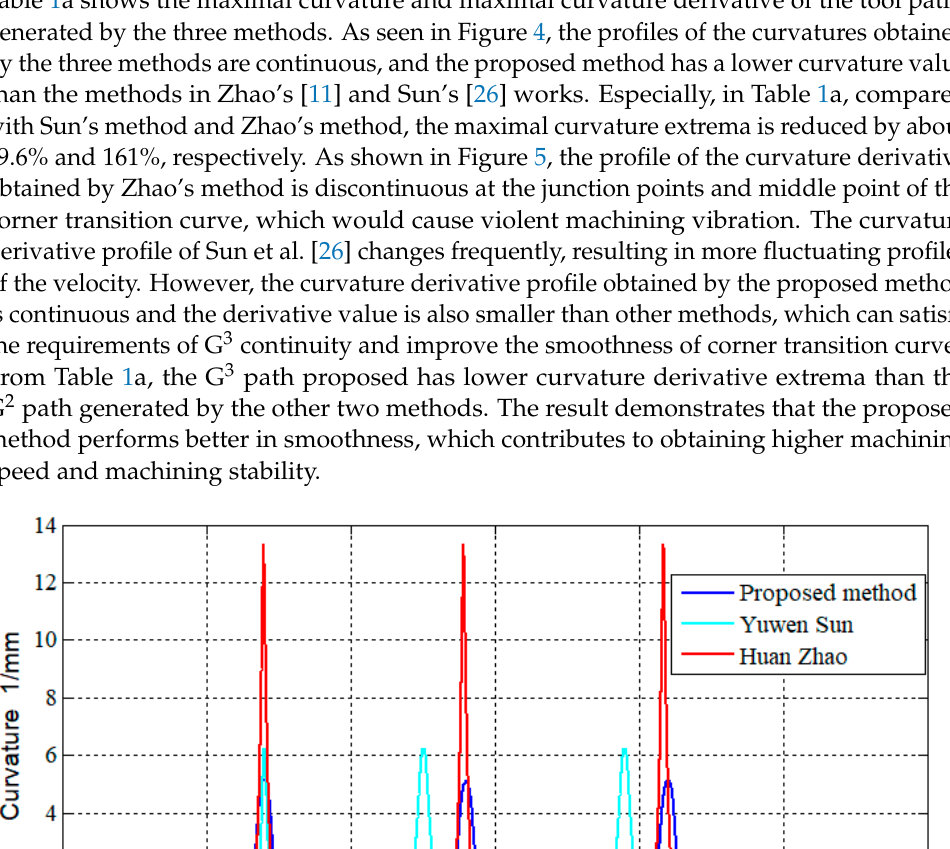
Table 1. The comparison between three methods.